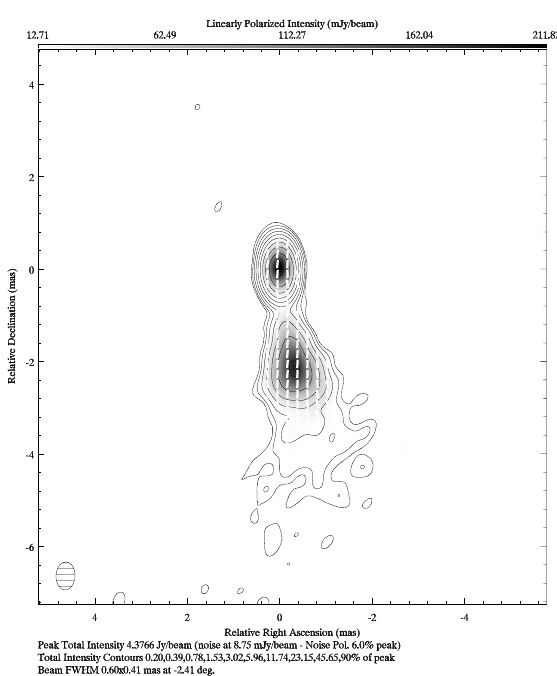
Figure 1. Very Long Baseline Array (VLBA) images of BL Lacertae at 15 GHz. Contours are the total intensity, grey scale represents the linearly polarized intensity, and the short sticks indicate the electric vector position angle.